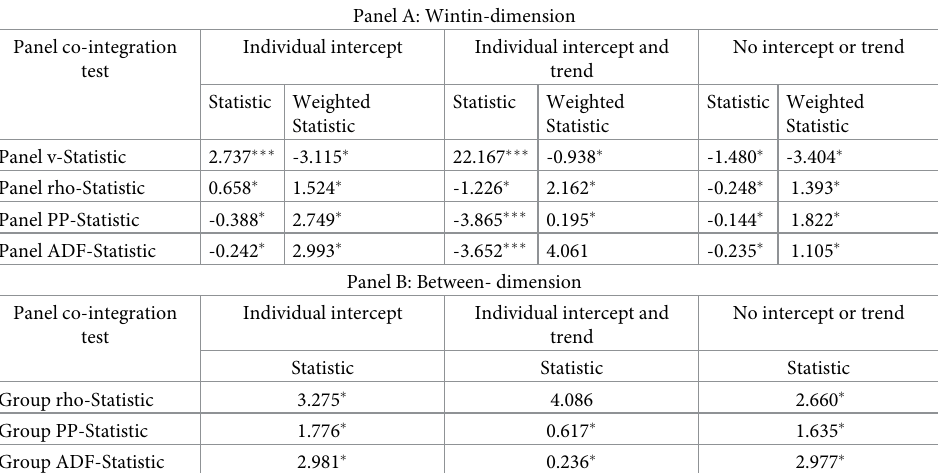
Panel A: Wintin-dimension